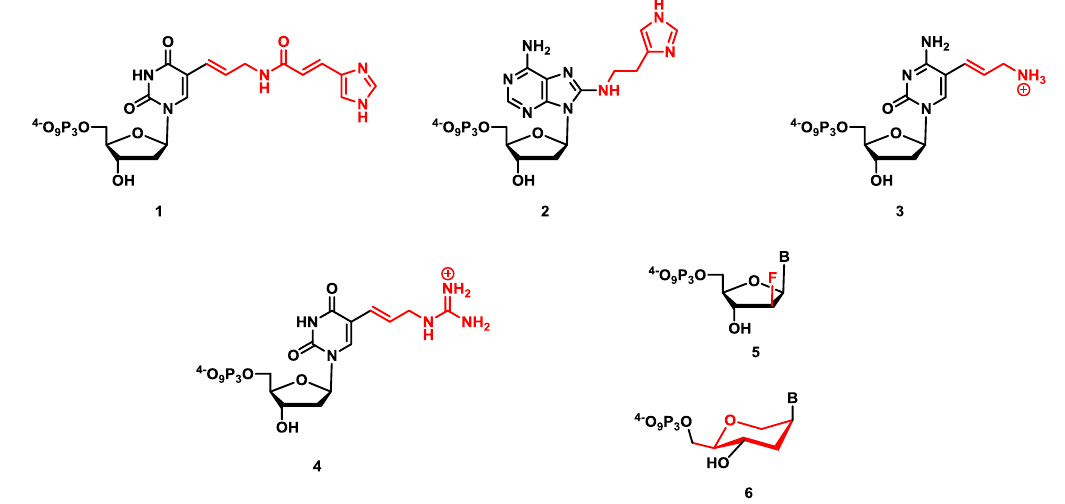
Figure 10. Chemical structures of modified nucleoside triphosphates (dN*TPs) used in in vitro selection experiments for the generation of modified DNAzymes: C5-imidazole-functionalized dUTP ( 1 ), dA im TP ( 2 ), dC aa TP ( 3 ), dU ga TP ( 4 ), FANA-NTPs ( 5 ), and HNA-NTPs ( 6 ). The chemical modifications are highlighted in red.